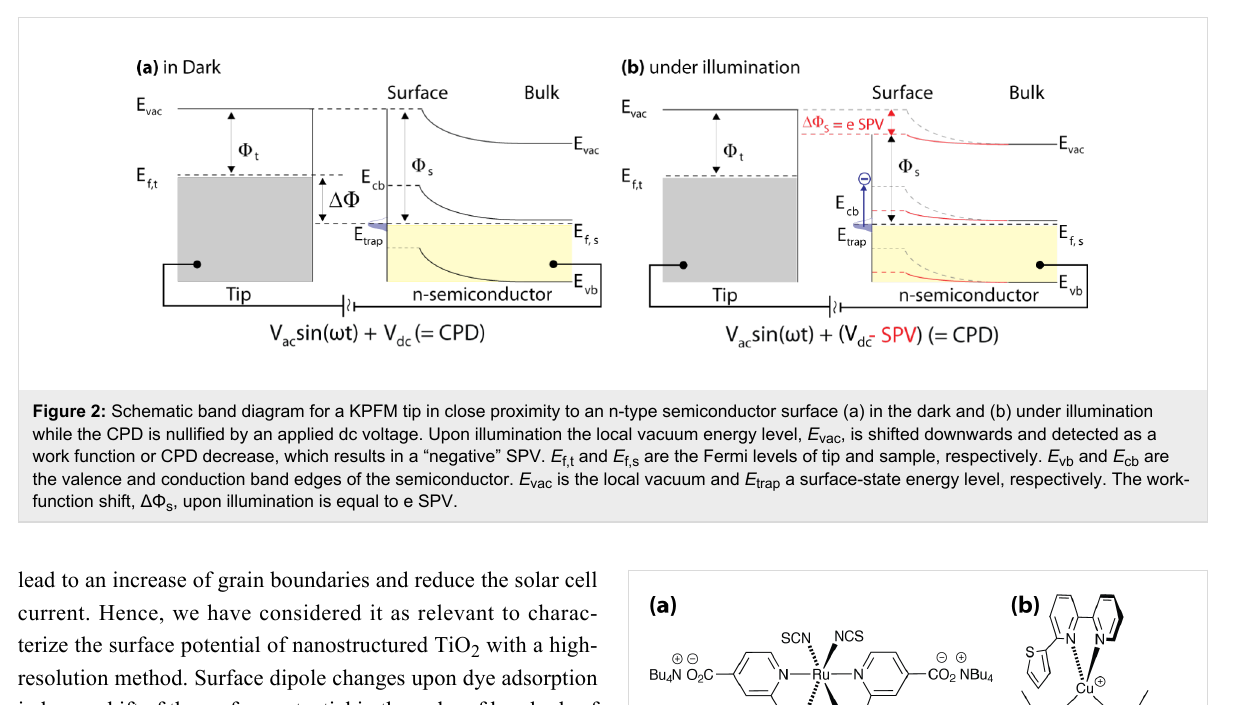
20–100 nm. Work-function ( Φ ) variations reflecting the pos- ition of the conduction band edge E cb of 80 mV on average, appear for both samples and are visible as dark regions in the measurements. They are highlighted in the cross sections in the lower part of the image. Such a local work function shift can be attributed to local variations of chemisorbed contaminants resulting in a decrease of the local vacuum energy, E vac , and the electron affinity, χ . A thin water layer consisting of chemisorbed and physisorbed H 2 O molecules on the nc-TiO 2